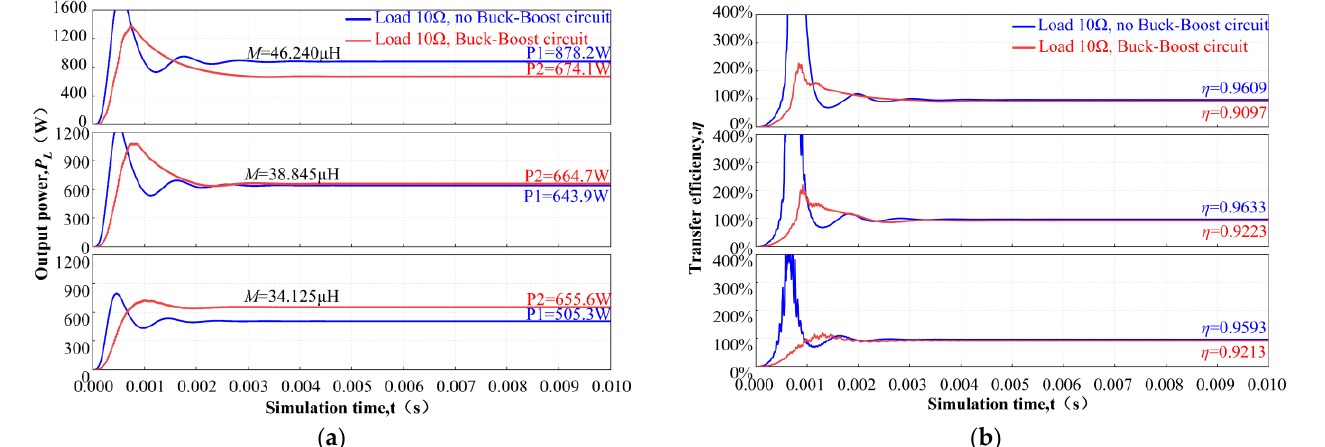
Figure 15. Power and efficiency variation under different mutual inductance for a load of 10 Ω . ( a ) Output power; ( b ) Efficiency.